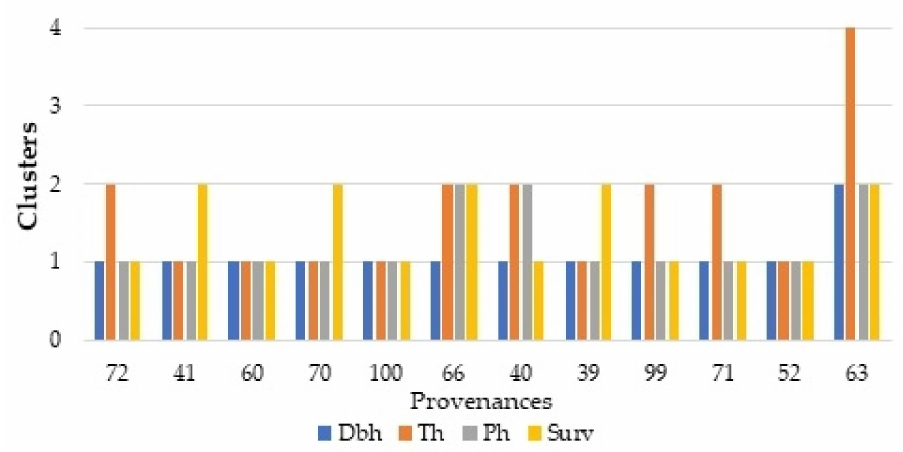
Figure 3. The grouping of the selected provenances using the MTSI index. 1: Performant and stable; 2: Performant but unstable; 3: Underperforming but stable; 4: Underperforming and unstable; Dbh: diameter at breast height; Th: total height; Ph: pruned height; Surv: survival